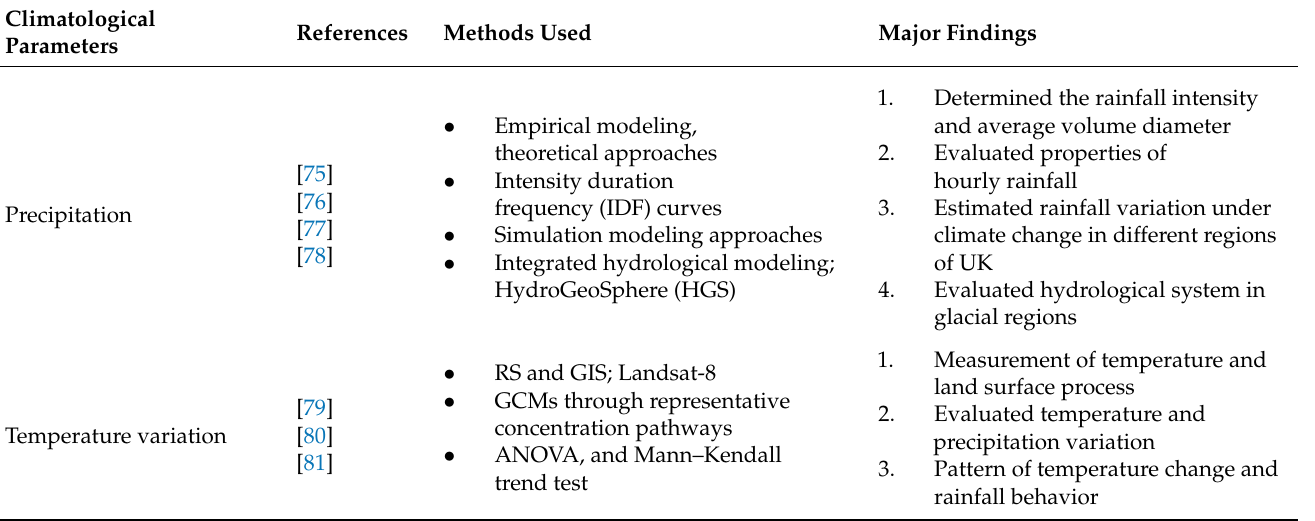
Table 2. State-of-the-art methods used to simulate climatological variables.